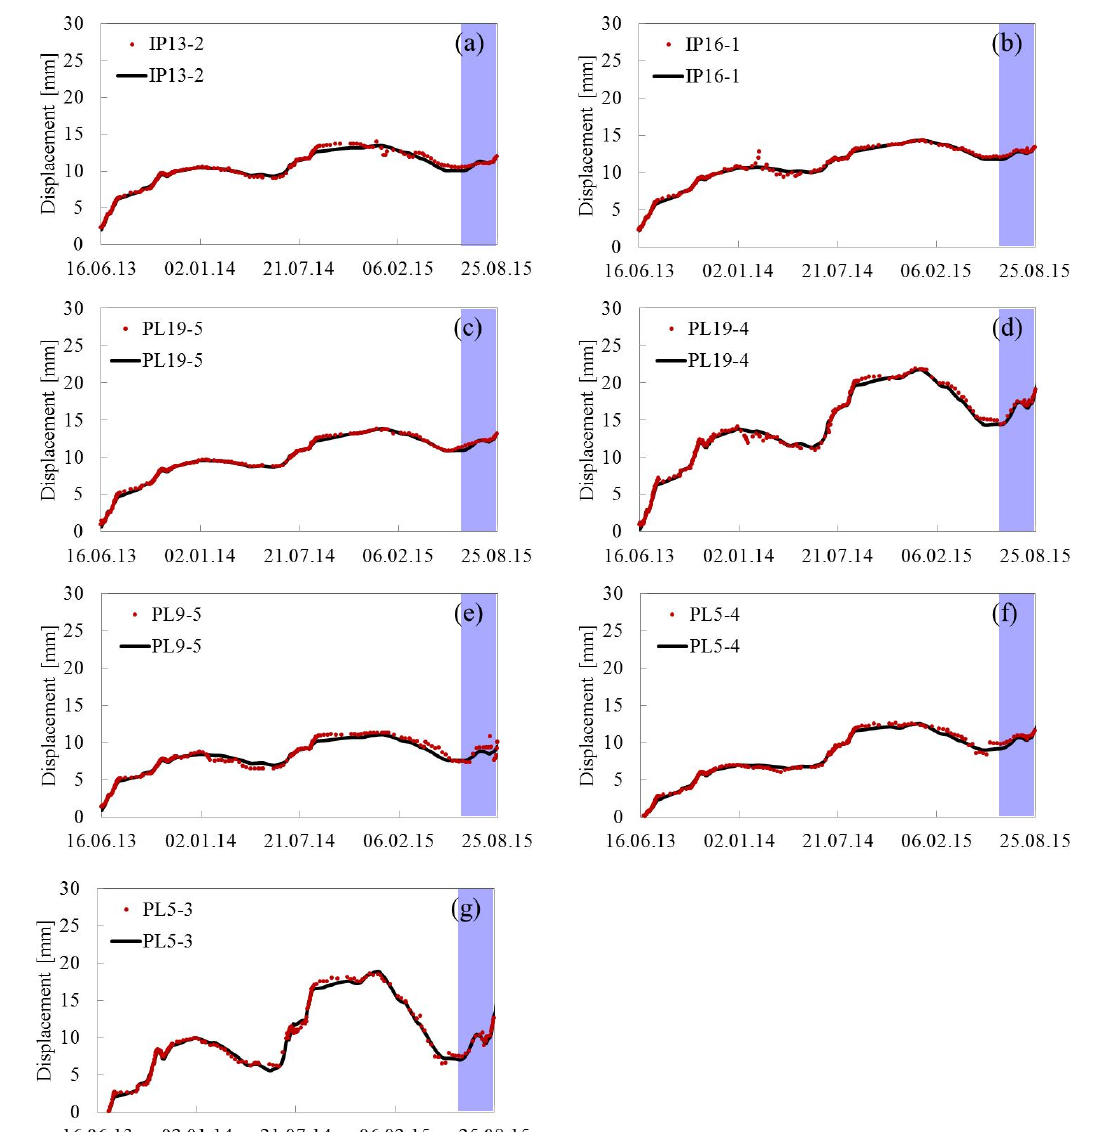
Figure 11. The fitting and predicting results of Class 1: ( a ) IP 13-2; ( b ) IP 16-1; ( c ) PL 19-5; ( d ) PL 19-4; ( e ) PL 9-5; ( f ) PL 5-4; ( g ) PL 5-3. The red dots represent the measured data, and the black lines are fitted and predicted data. The model was developed with the data in the white area and validated by the data in the blue area. The positive direction is